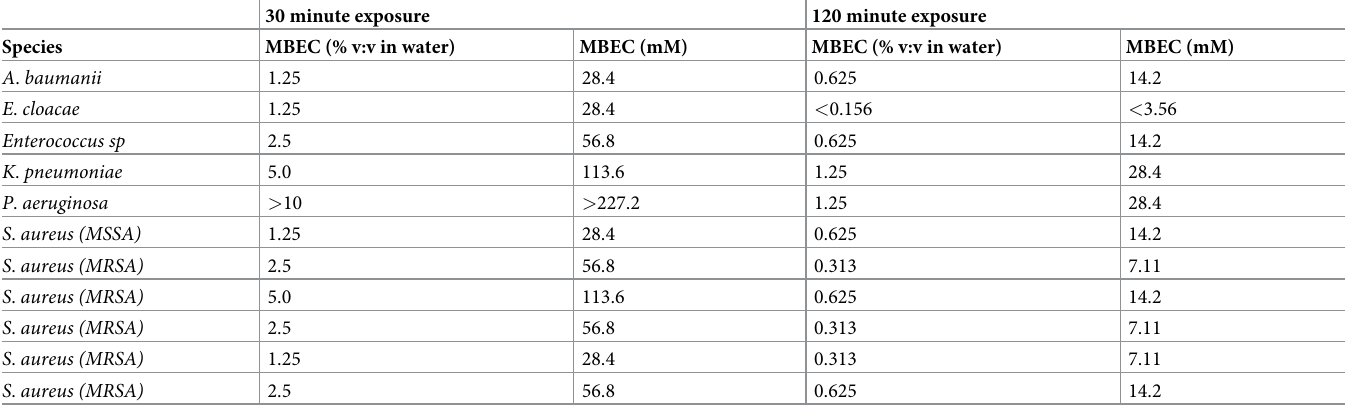
Table 2. Observed minimal biofilm eradication concentrations (MBEC) for 30 and 120 minute exposures of dilute CAGE against 72 hour old biofilms of selected ESKAPE pathogens. Each MBEC value represents the largest of three (n = 3) independent measurements. 30 minute